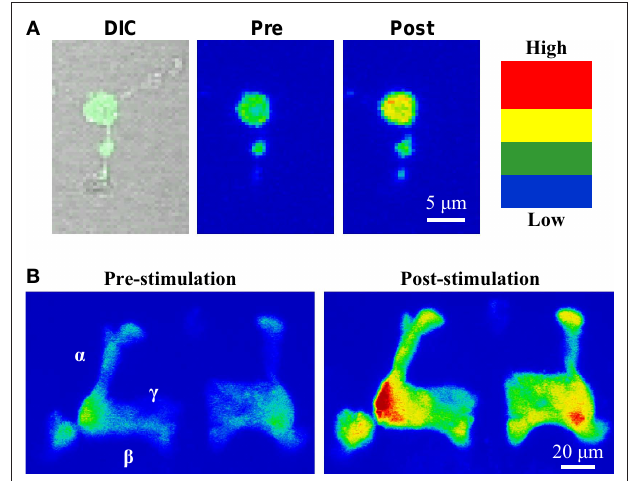
FIGURE 5 | Use of transgenic calcium reporter gCAMP to visualize synaptic activity. (A) OK107-GAL4 driving UAS-gCAMP in primary neuron culture before and after depolarization. (B) OK107-GAL4 driving UAS-gCAMP in whole brain Mushroom Body axonal lobes ( α , β , γ ). Depolarization causes fl uorescence increases throughout the Mushroom